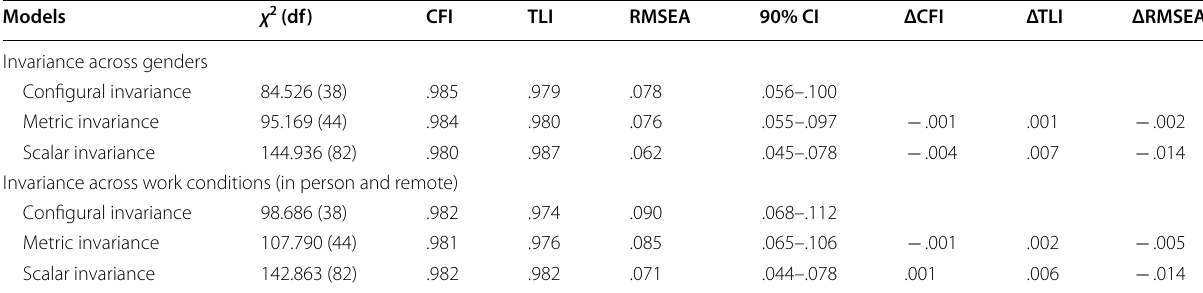
Table 2 Invariance models